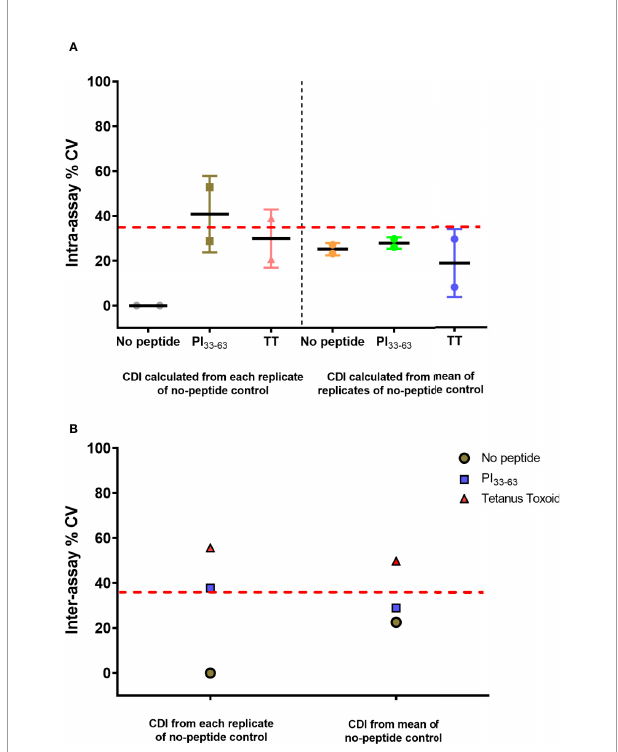
FIGURE 7 | CD4 + CDI to PI 33-63 and tetanus toxoid using cryopreserved PBMCs from a single patient with T1D ≤ 3 months. Assays were performed independently by two analysts. The mean CDI of triplicate measurements was calculated and the % Coef fi cient of Variation (CV) is shown. Each data point represents % CV. The solid lines represent mean % CV (intra-assay repeatability). The dashed red lines indicate the recommended threshold limit of CV ≤ 35% (18). (A) Intra-assay repeatability for CD4 + T-cell proliferative responses within assays performed by two independent analysts. (B) Inter- assay reproducibility for CD4 + T-cell proliferative responses between assays performed by two independent